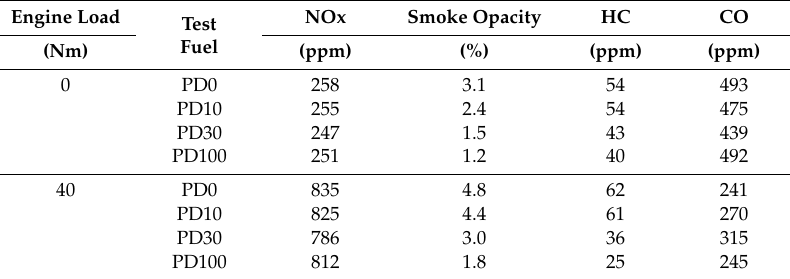
Table 7. Regulated gaseous emissions under test conditions.